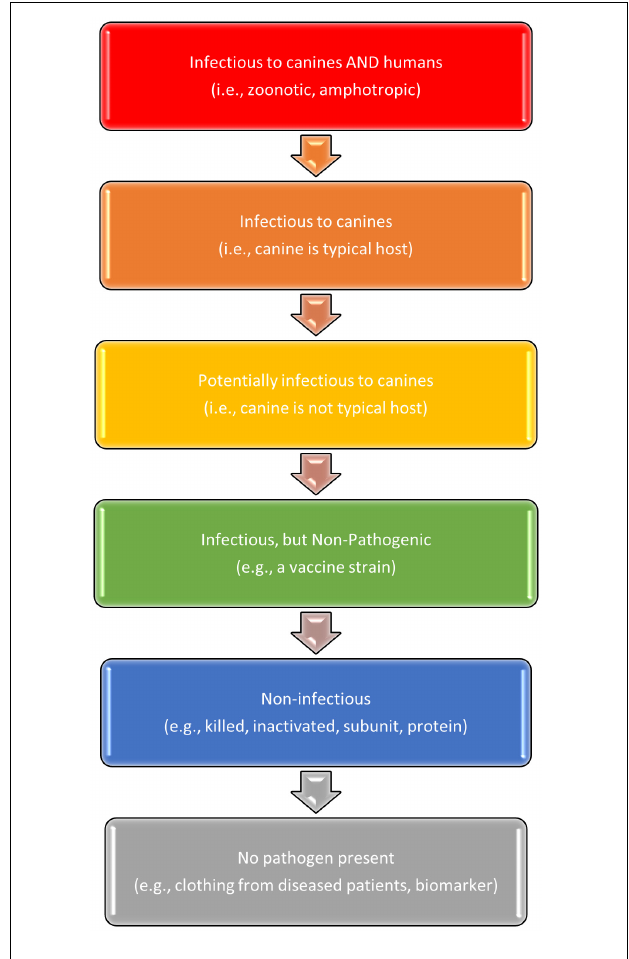
FIGURE 3 | Selection of canine training aids for biomedical detection dogs.